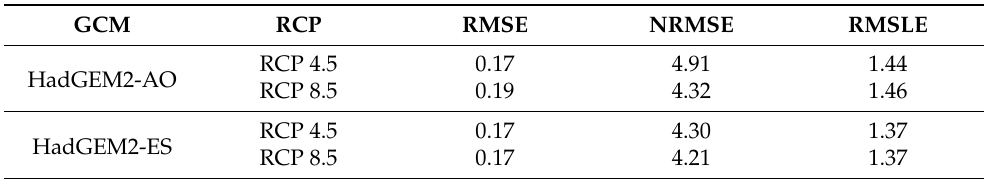
Table 3. Performance results corresponding to GCM and